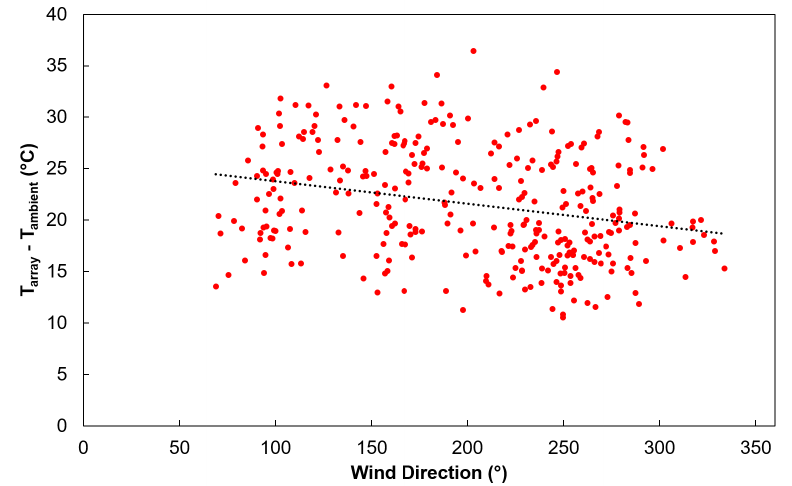
Figure 8. Wind speed vs. temperature difference between ambient and array.